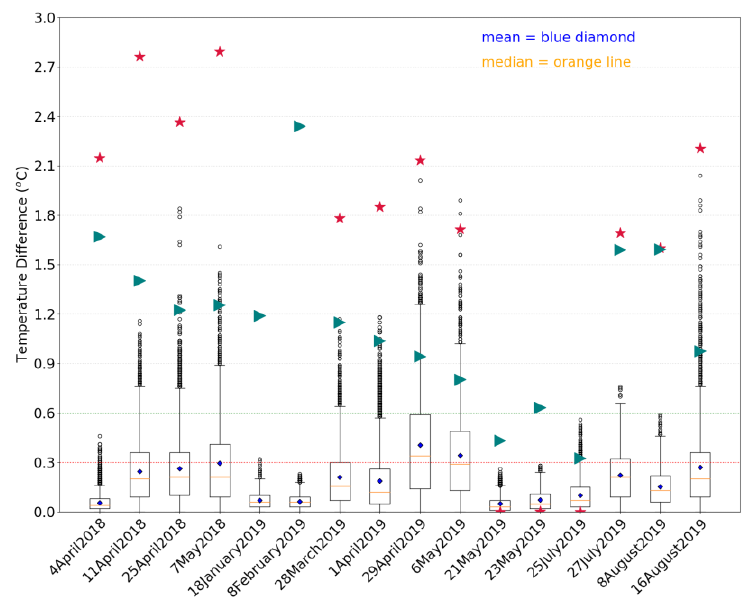
Figure 3. Boxplots of temperature differences (°C) for all iMET-XQ pairs by date for the 16 Tower experiments (including the 3 dusk days). Red stars represent relative solar radiation values averaged over the duration of each experiment. Green triangles represent relative 2 m wind speed values averaged over the duration of each experiment. Table 1 provides the actual values of mean solar radiation and mean 2 m wind speed values. The temperature difference means are represented by blue diamonds, the medians are shown by orange lines. A temperature difference of 0.3 °C is marked by a red dotted line. A temperature difference of 0.6 °C is marked by a green dotted line.